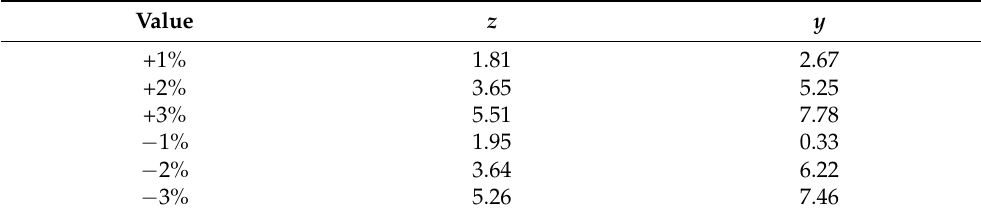
Table 8. Modification (increment or reduction in %) in buckling normal stress value between different values of height and width torsion box.